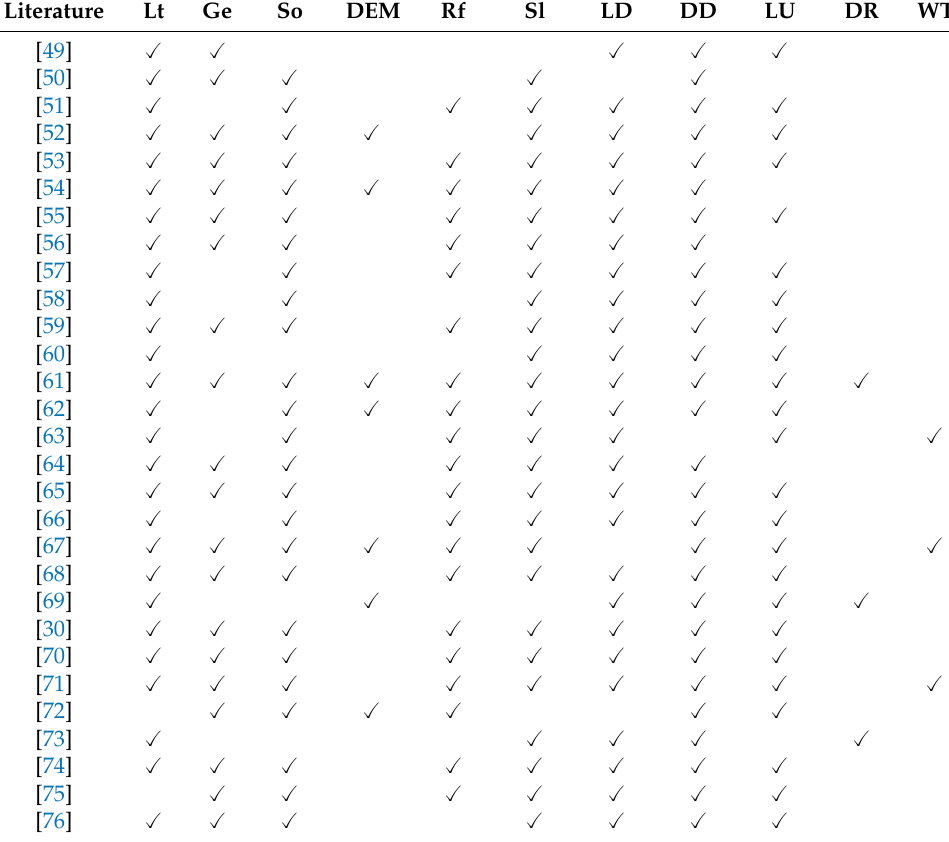
Table 2. Literature review of the thematic layers used to delineate groundwater potential zones